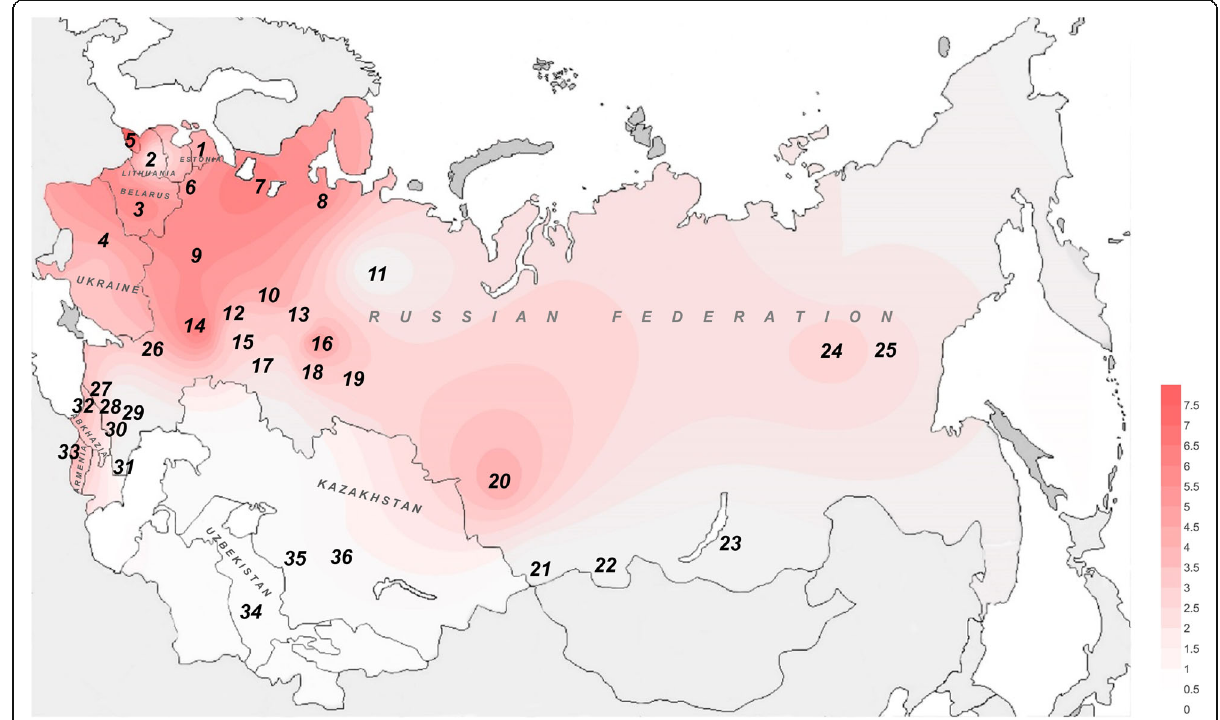
Fig. 1 Distribution of the c.35delG carrier frequency on the territory of Russia and in some countries of the former Soviet Union. The c.35delG carrier frequencies (%) were obtained from all available data published up to 2018 (Additional file 1: Table S1). Codes from 1 to 36 indicate analyzed samples (region under study and/or ethnicity which were indicated in the original publications). In some cases, c.35delG carrier frequency was calculated by us from the data given in original publications. The maximum value of the c.35delG carrier frequency is used for the figure if there are several data sets for a region or an ethnically stratified sample. Codes 1 – 4 – Northern and Eastern Europe : 1 – Estonia (4.4 – 4.5%), 2 – Lithuania